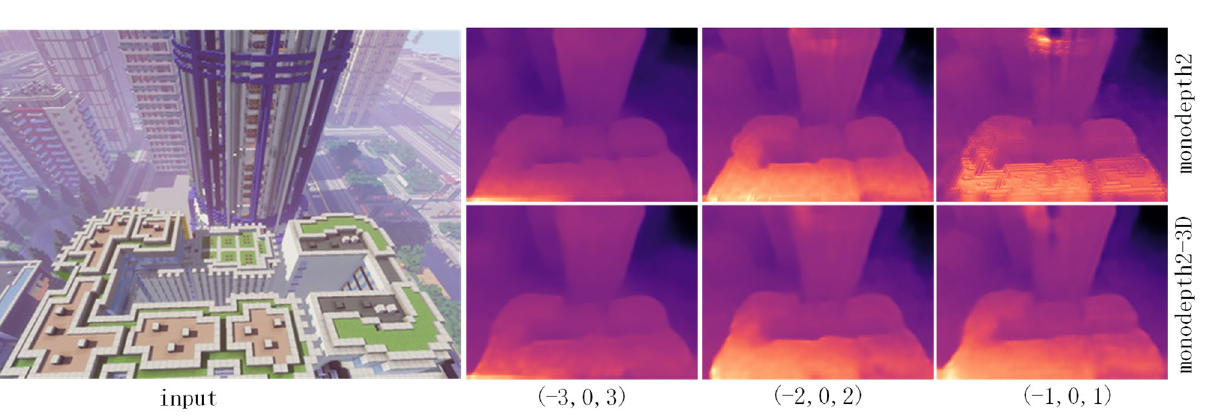
Figure 13. Qualitative model results in MineNavi. First row: monodepth2. Second row: monodepth2-3D. From left to right, the velocity of training sequence is getting